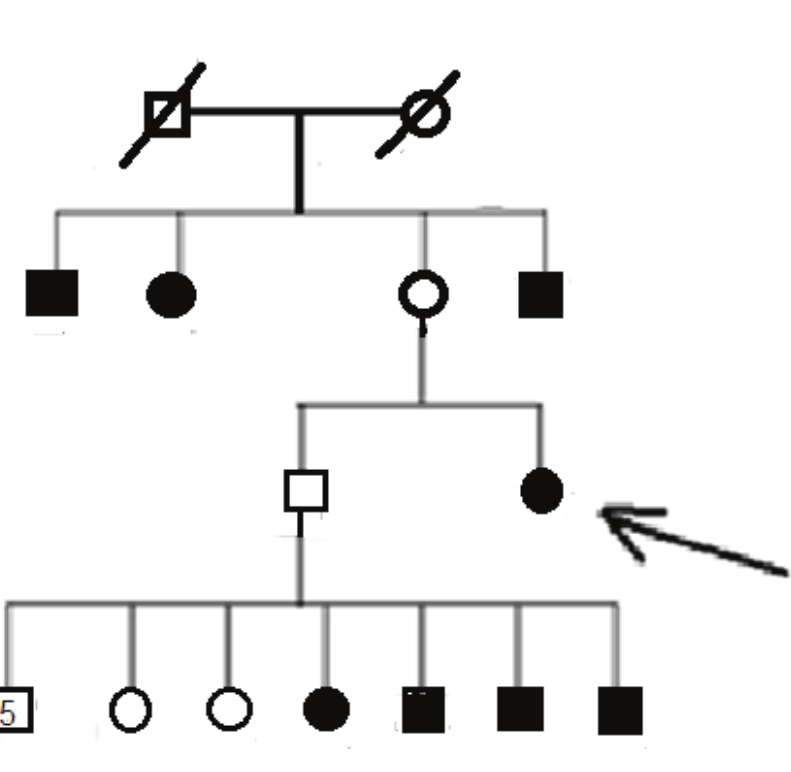
Figure 3 : Pedigree of the third family from the Northern State, Sudan with familial Bell’s palsy with eight (five male and three female) affected individuals across three generations. The black arrow shows the index case. ( Note: The numbers inside the circles and rectangles indicate female and male family members in different generations and their subsequent generations who were unaffected by Bell’s palsy.